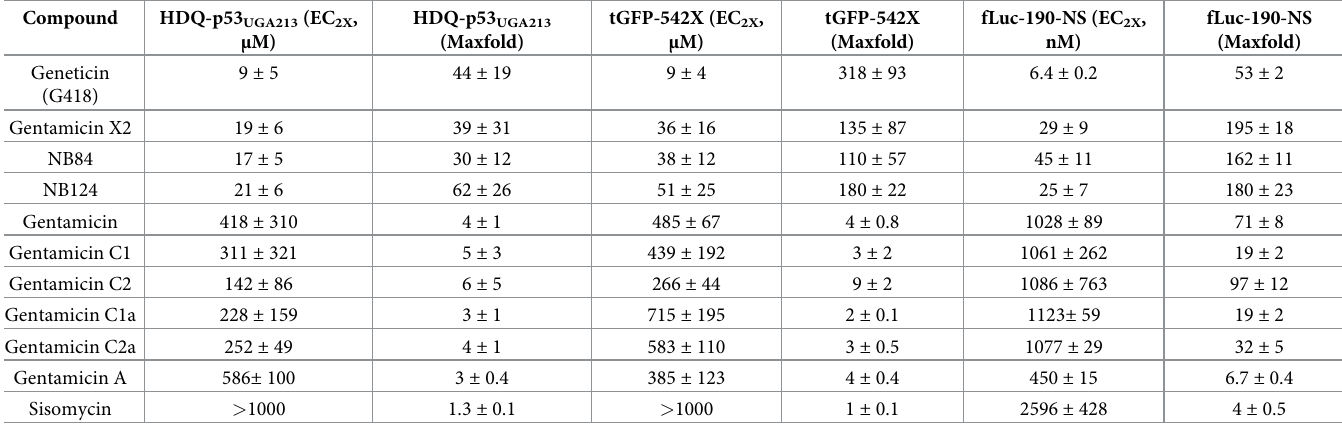
Values are reported as averages plus or minus the standard deviation for at least three separate experiments. [7;12;31]. EC 2X : concentration required to double the level of full-length p53 protein. Maxfold: maximum readthrough activity achieved above background. All values used for calculating averages can be found in S1 File. Note: maximum fold values for gentamicin X2 and G418 differ in Table 1 from that in Fig 1B because the highest concentration used for the measurements in Table 1 was 300 μ M whereas Fig 1B was 1000 μ